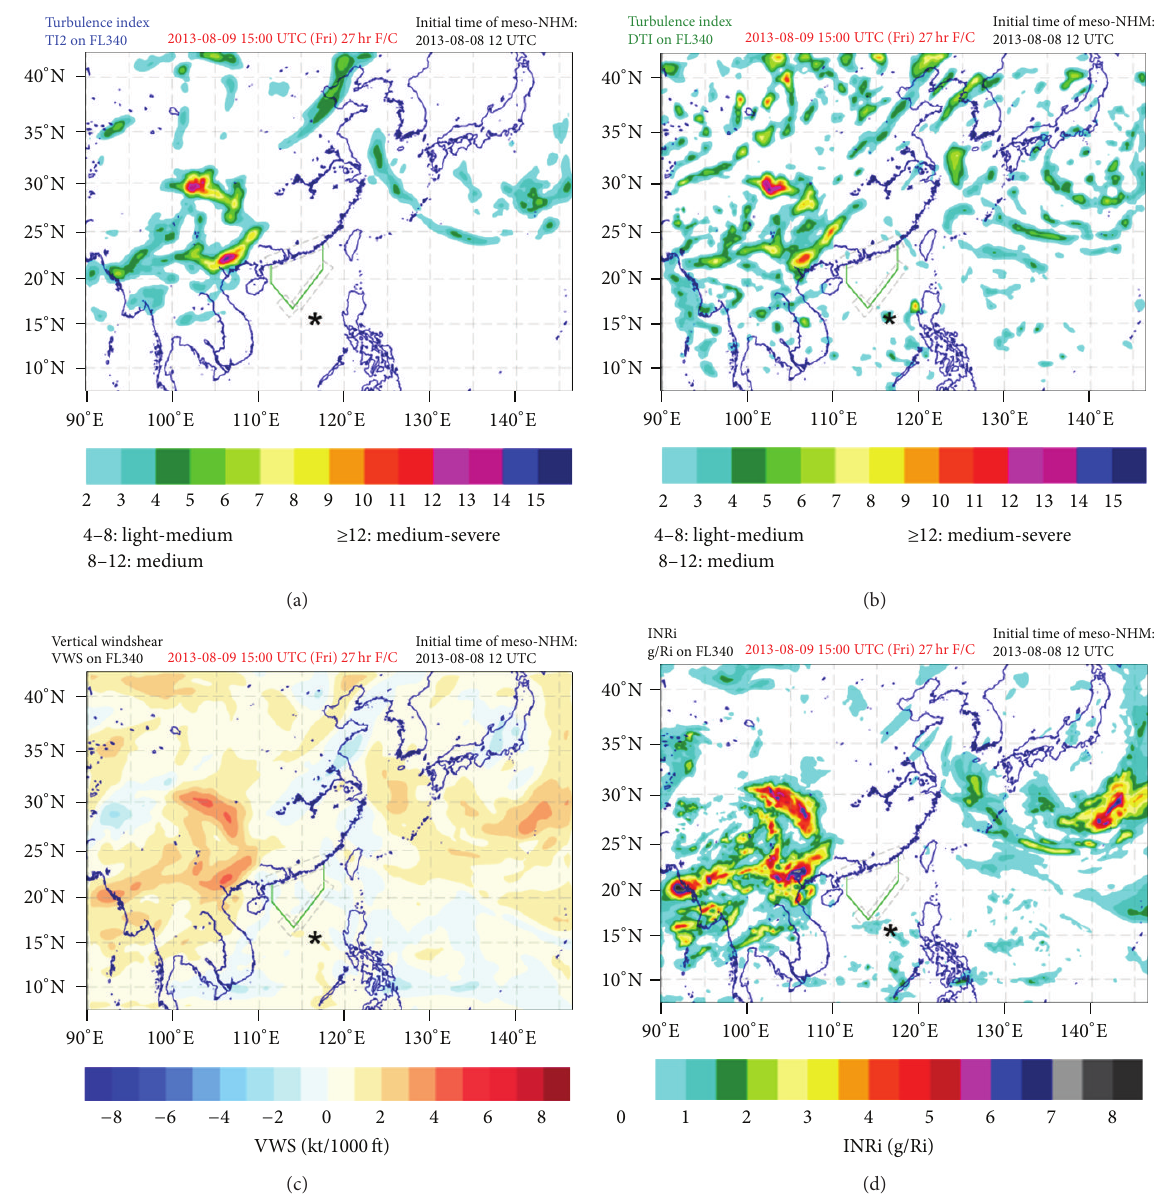
Figure 9: Similar to Figure 8 but for T+27-hour forecast. The asterisk shows the location of the turbulence